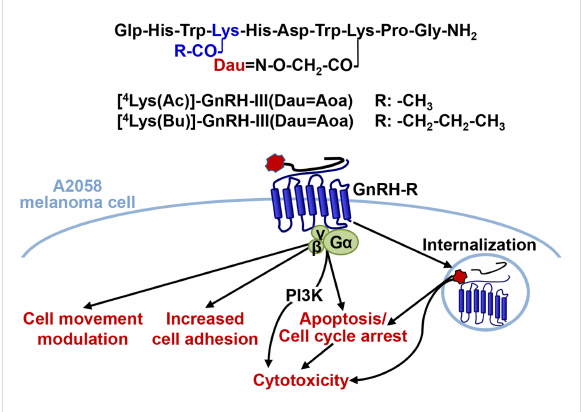
Figure 8: Schematic representation of the proposed mechanisms of the effects of GnRH-III conjugates containing acylated 4 Lys in A2058 melanoma cell line. Dau: